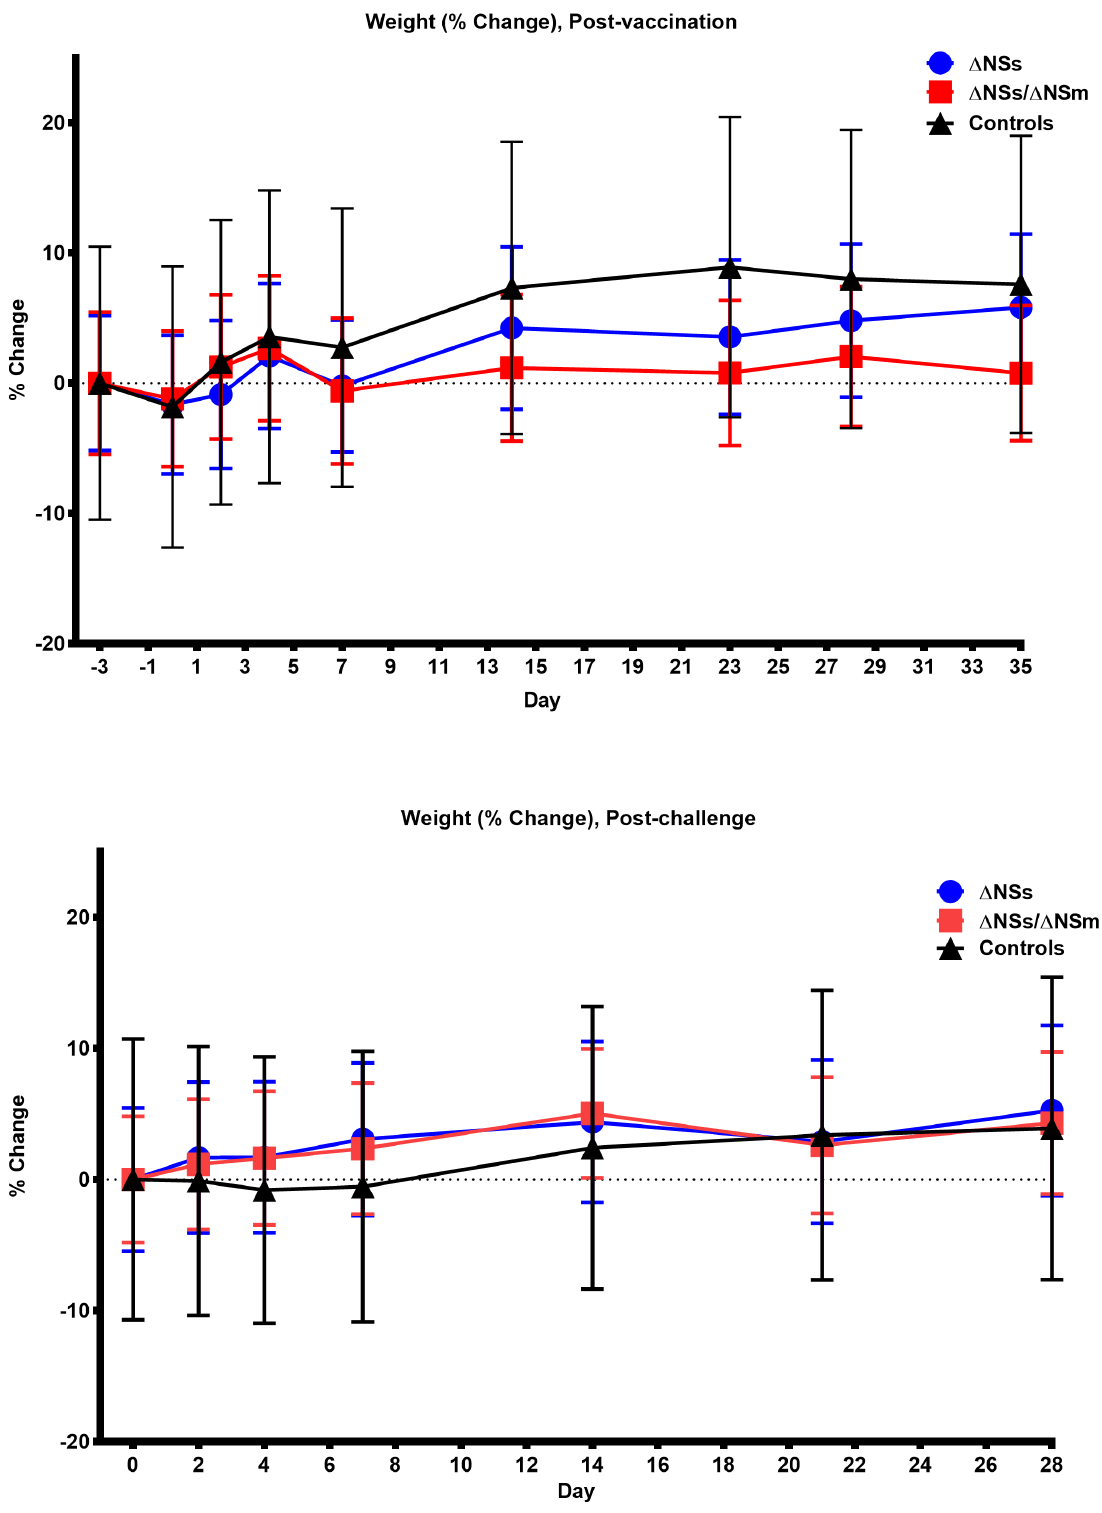
Fig 1. Weights of marmosets post-vaccination (top) and post-challenge (bottom). Percent change in baseline of weights of marmosets post-vaccination (top) with rZH501- Δ NSs (n = 6), rZH501- Δ NSs- Δ NSm (n = 6), or sham inoculated controls (n = 5) and post-challenge (bottom) with 6 log 10 PFU of the virulent strain ZH501. The symbols represent the mean value and the error bars represent the standard error of the mean. https://doi.org/10.1371/journal.pntd.0006474.g001 PLOS NeglectedTropical Diseases | https://doi.org/10.1371/journal.pntd.0006474 May 9,